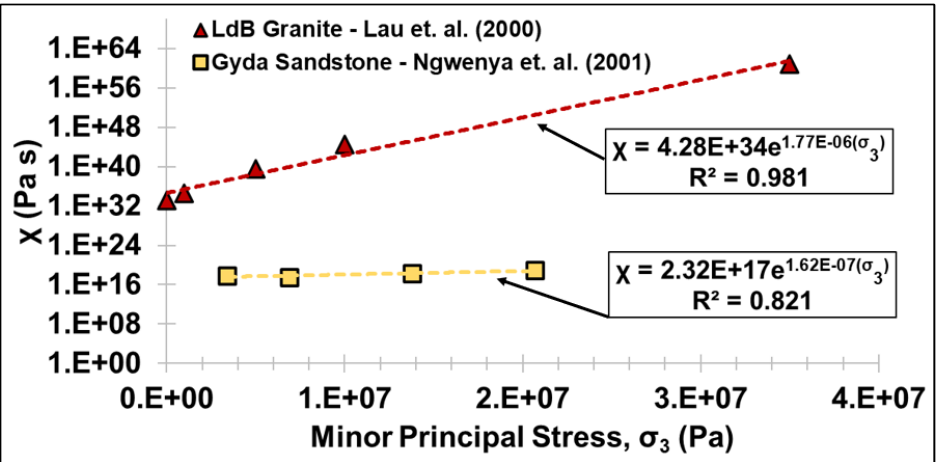
Figure 9. Plot of variable χ versus confinement for LdB granite from [77] and Gyda sandstone from [91].